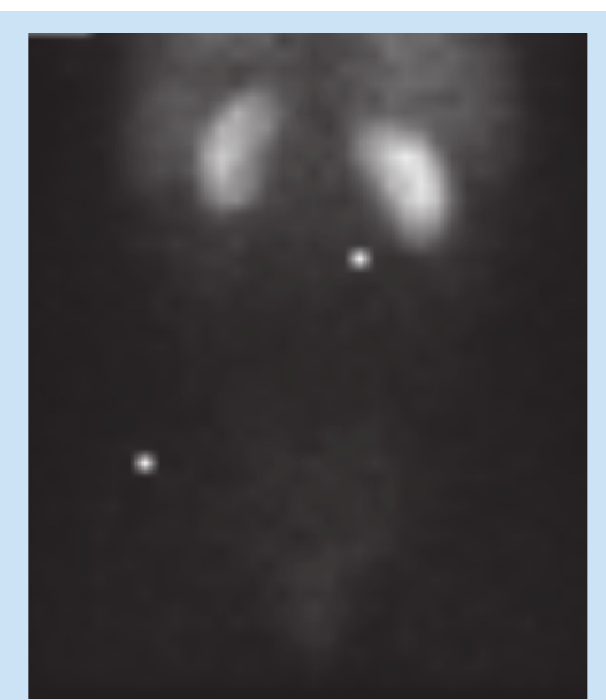
Fig. 4. Tc-99m DTPA scintigraphy in coronal posterior-anterior view demonstrates that the left kidney is smaller than the right, but both kidneys demonstrate normal tracer